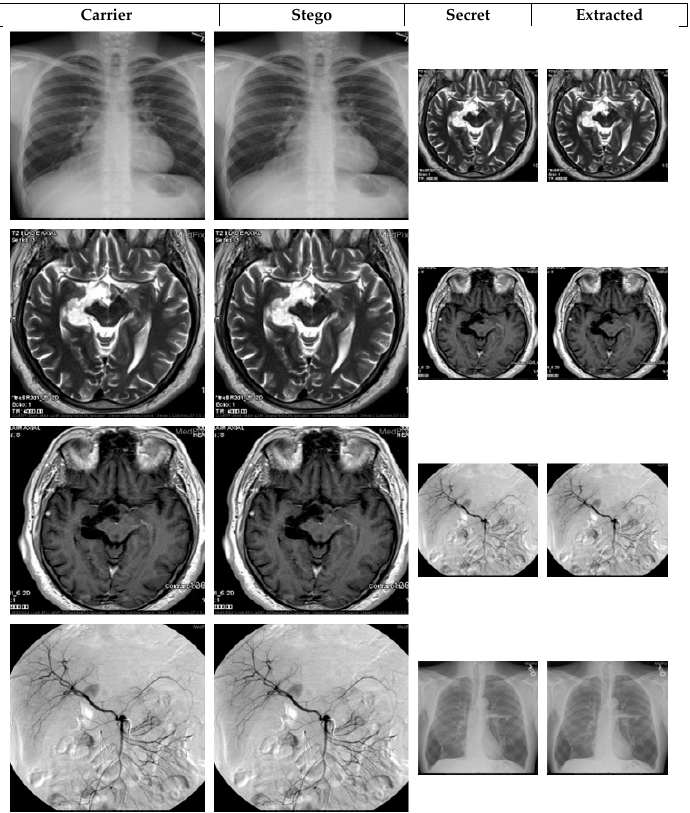
Figure 5. Visual quality for marked (i.e. stego) versions of greyscale images in Figure 3.